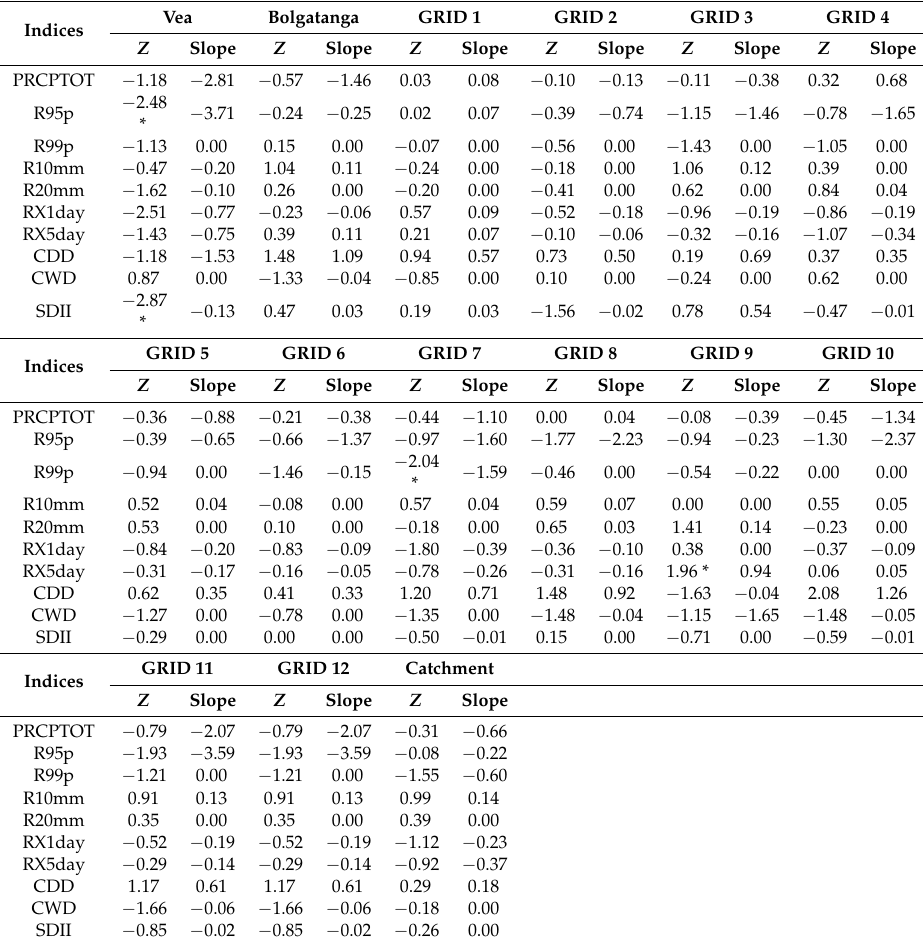
Table 6. Mann–Kendall (MK) Trend Statistics of Rainfall Extreme Indices.